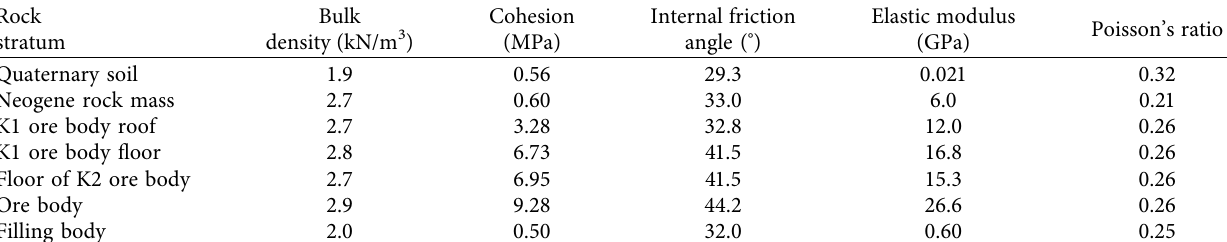
Figure 10: Calculation curve of Hoek–Brown criterion for roof rock mass of K1 ore Table 1: Summary of rock mass mechanical parameters.